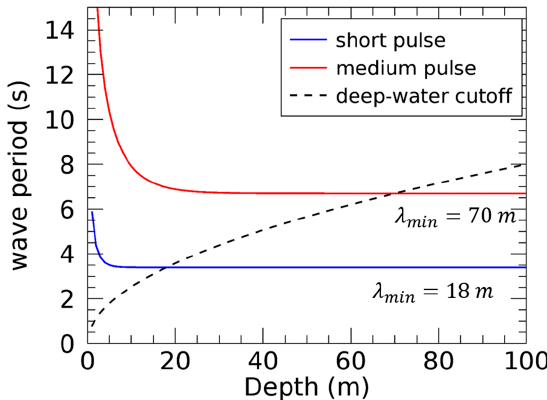
Figure 11. Wave period in function of the bathymetry for theoretical values of minimum wavelength detectable in short pulse (blue line) and medium pulse (red line) modes, together with the theoretical curve of the deep-water cutoff (black dashed line).